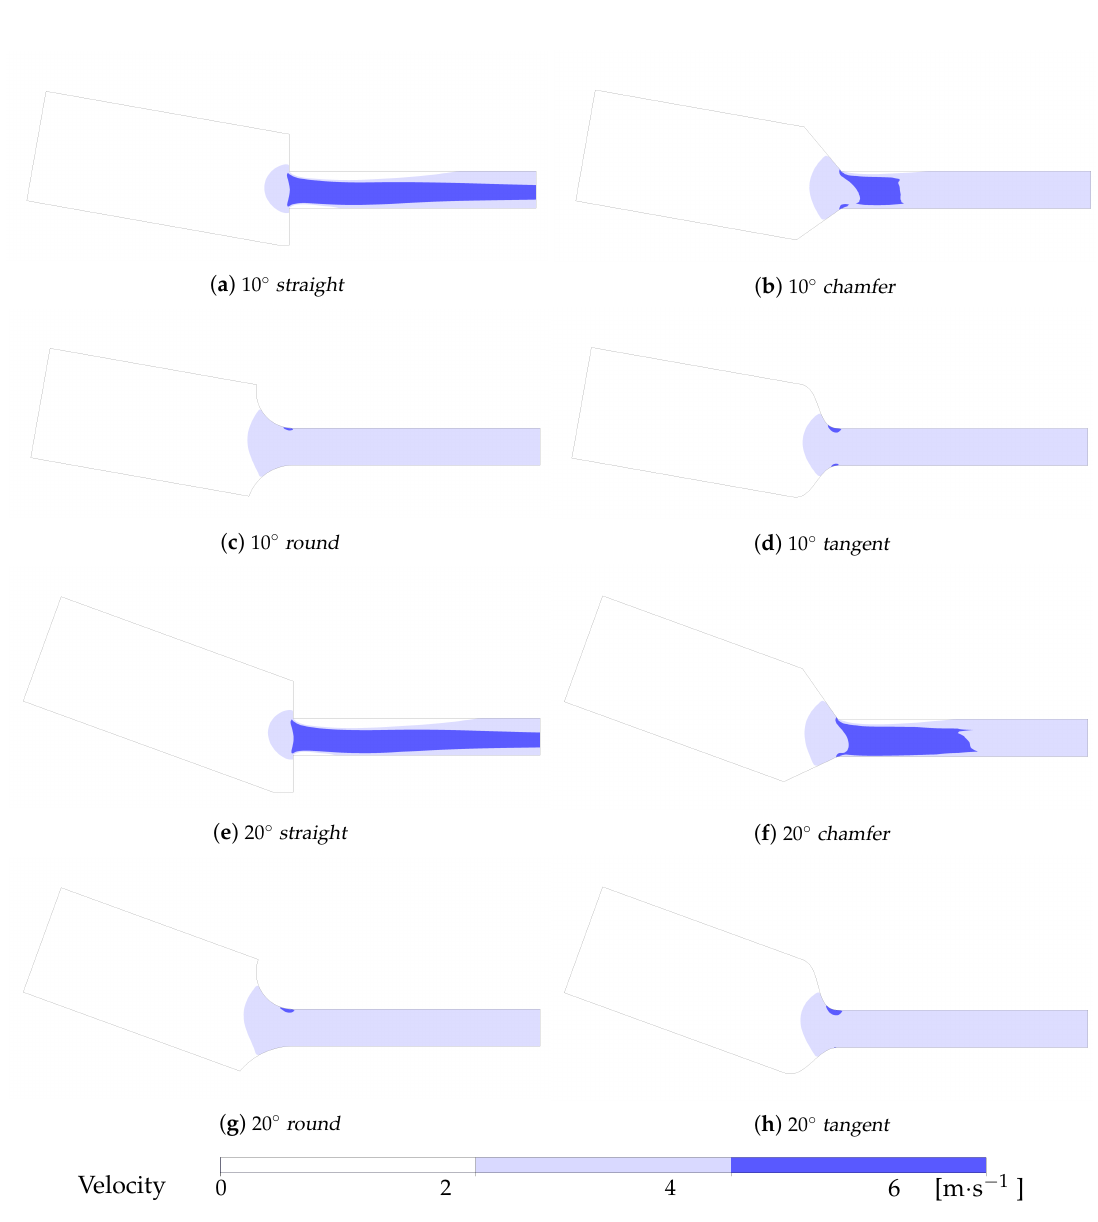
Figure A2. Velocity Contours for 10 ◦ and 20 ◦